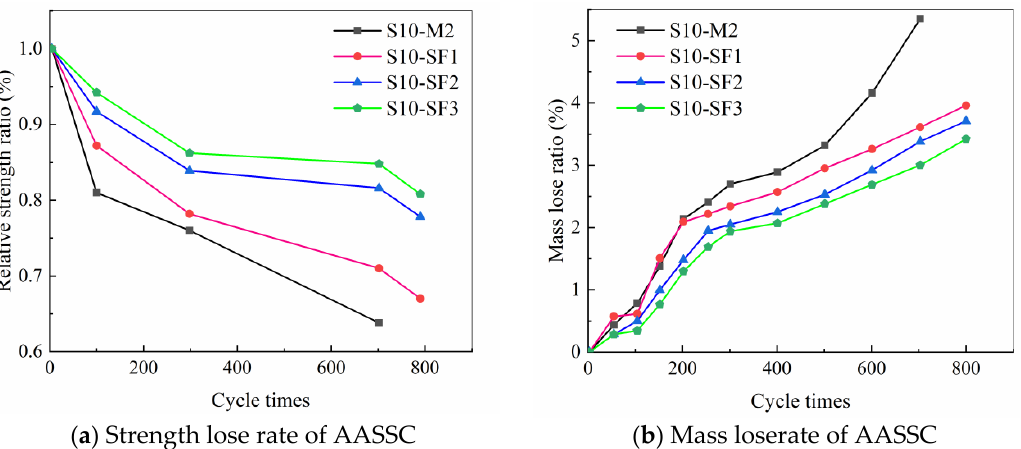
Figure 10. The influences of different steel fiber content on the freeze-thaw resistance of AASSC where relative strength ratio is that the compressive strength of sample before test versus the compressive strength of sample after test.